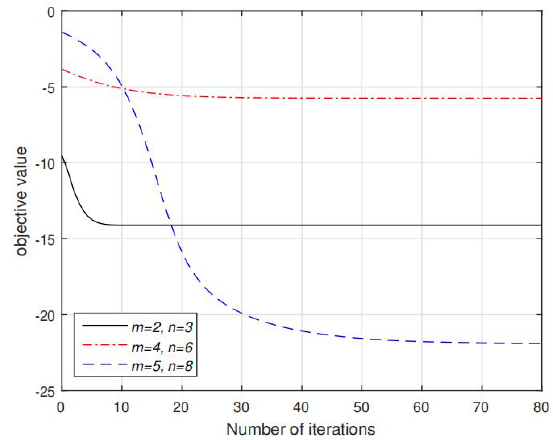
Figure 8. Convergence of f k in Algorithm 2 as function of iteration k under different settings of m , n . µ is fixed with 0.5.